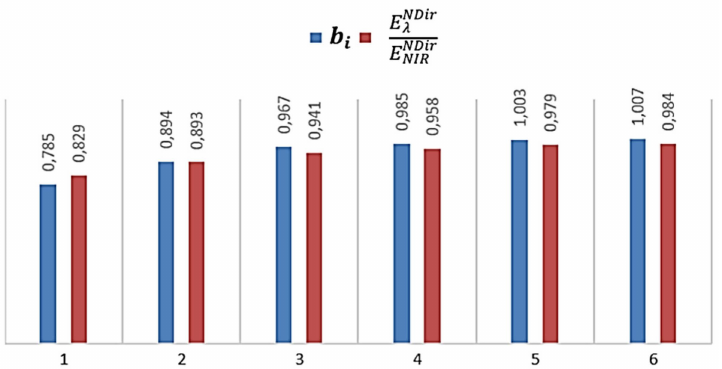
Figure 6. Slope b i , obtained by linear fitting ( blue ); and optical-band/NIR direct irradiance ratio ( red